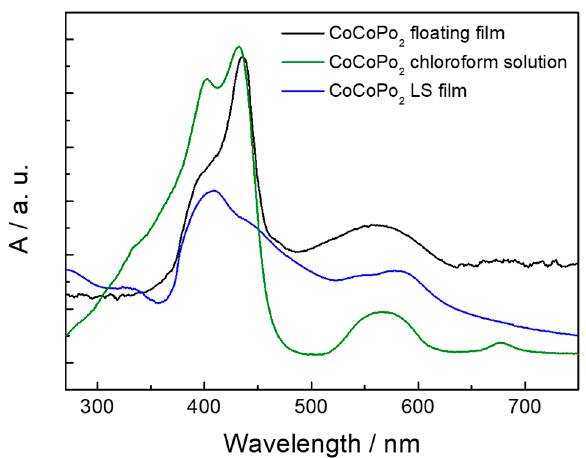
Figure 7. UV-VIS electronic absorption spectra of the CoCoPo 2 macrocycle as floating film, in chloroform solution and in L-S thin film form deposited onto silica glass substrate. Reflection spectrum of the floating film (black line), recorded at 30 mN · m − 1 ,